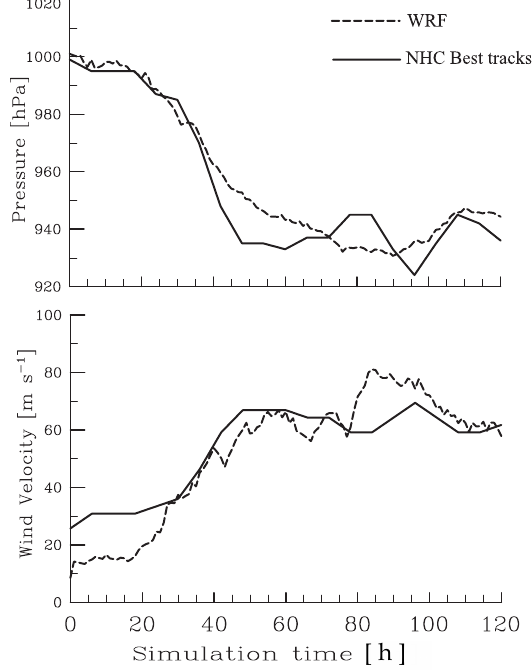
Figure 1. Maximum azimuthally averaged tangential wind velocity and minimum sea level pressure (hourly, dashed lines) in the inner core of the Weather Research and Forecasting (WRF) integration for Hurricane Igor (2010), and corresponding National Hurricane Center Best-Track information (6 hourly, solid